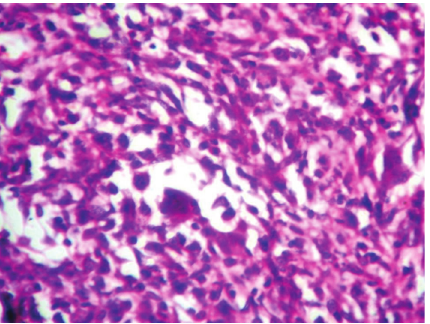
Figure 3: Osteoclastic type of giant cells and cellular stroma (H and E ×